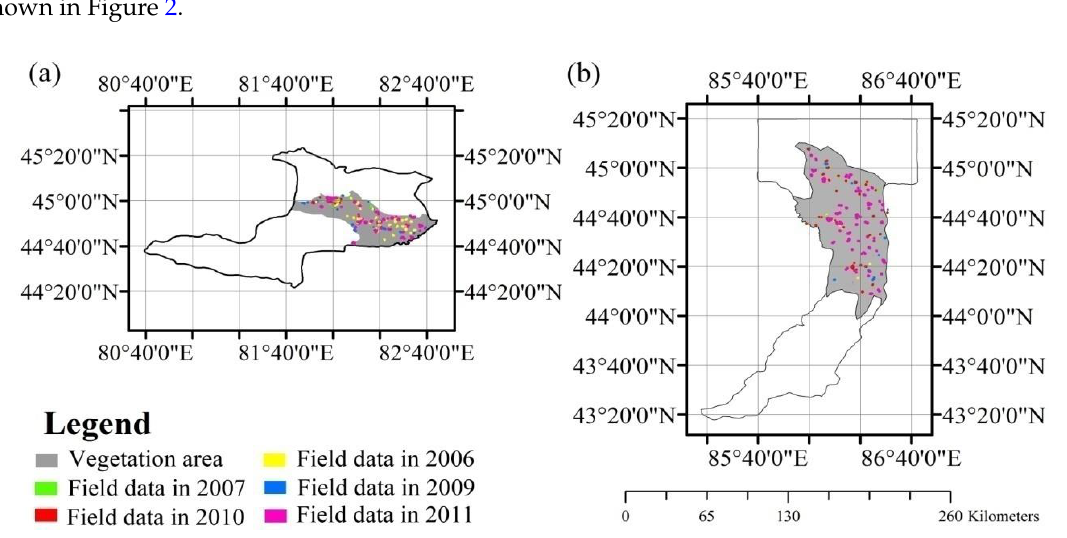
Table 4. The number of historical samples (pixels at 250 m) by year and crop